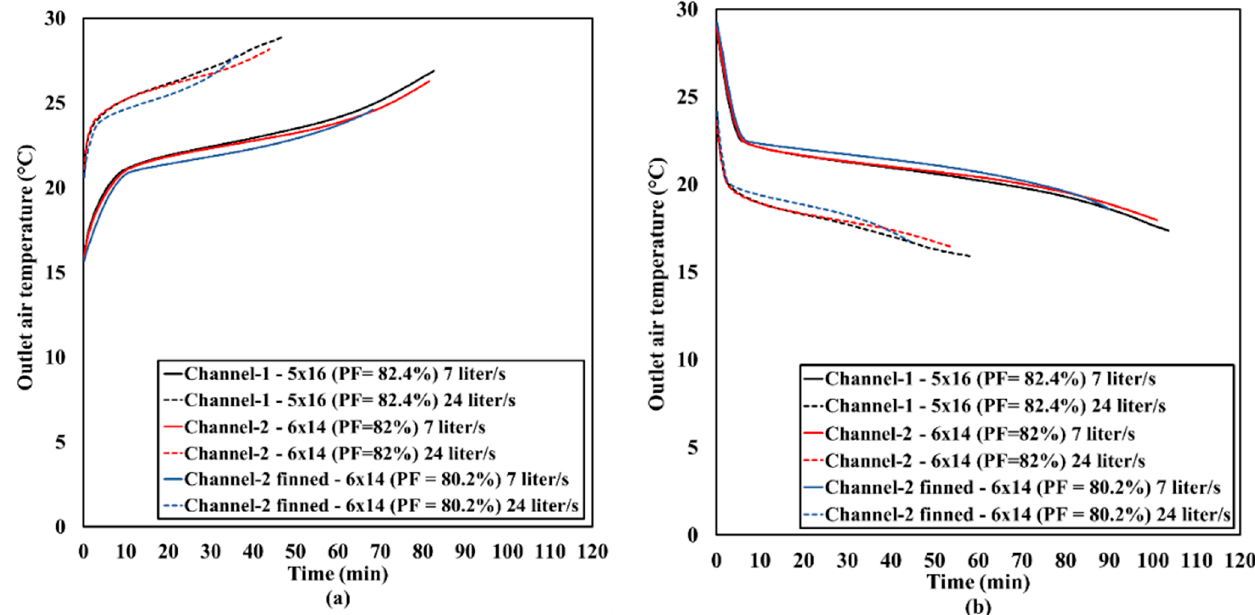
Figure 8. Transient outlet air temperature of flow rates of 7 and 24 L/s: ( a ) melting-Tin = 30 °C, ( b ) solidification-Tin = 15 °C.